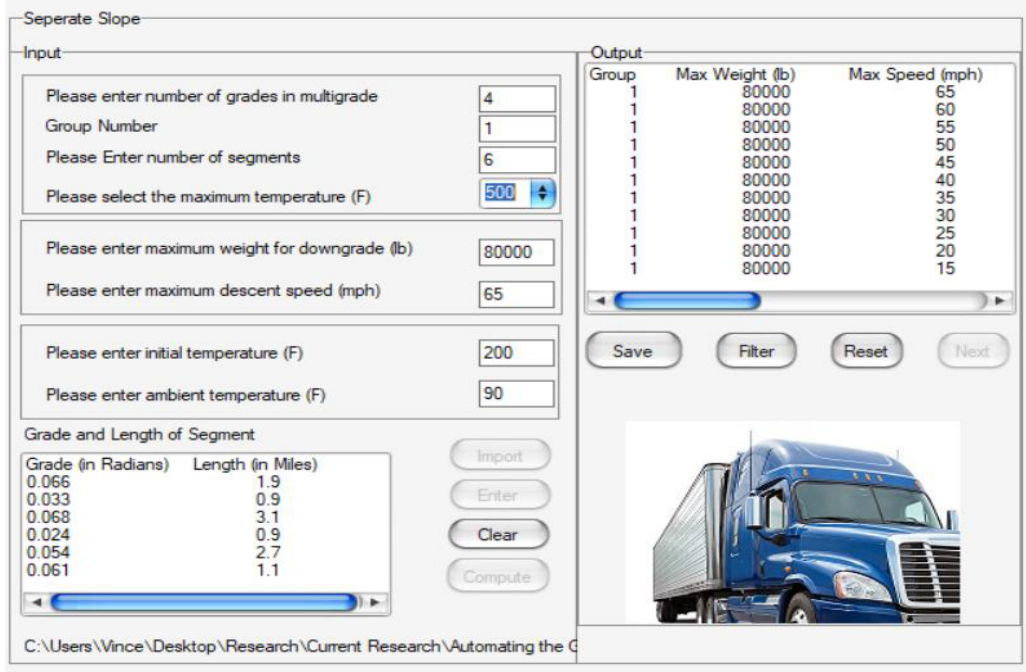
Figure 6: Separate downgrade analysis option: Braking